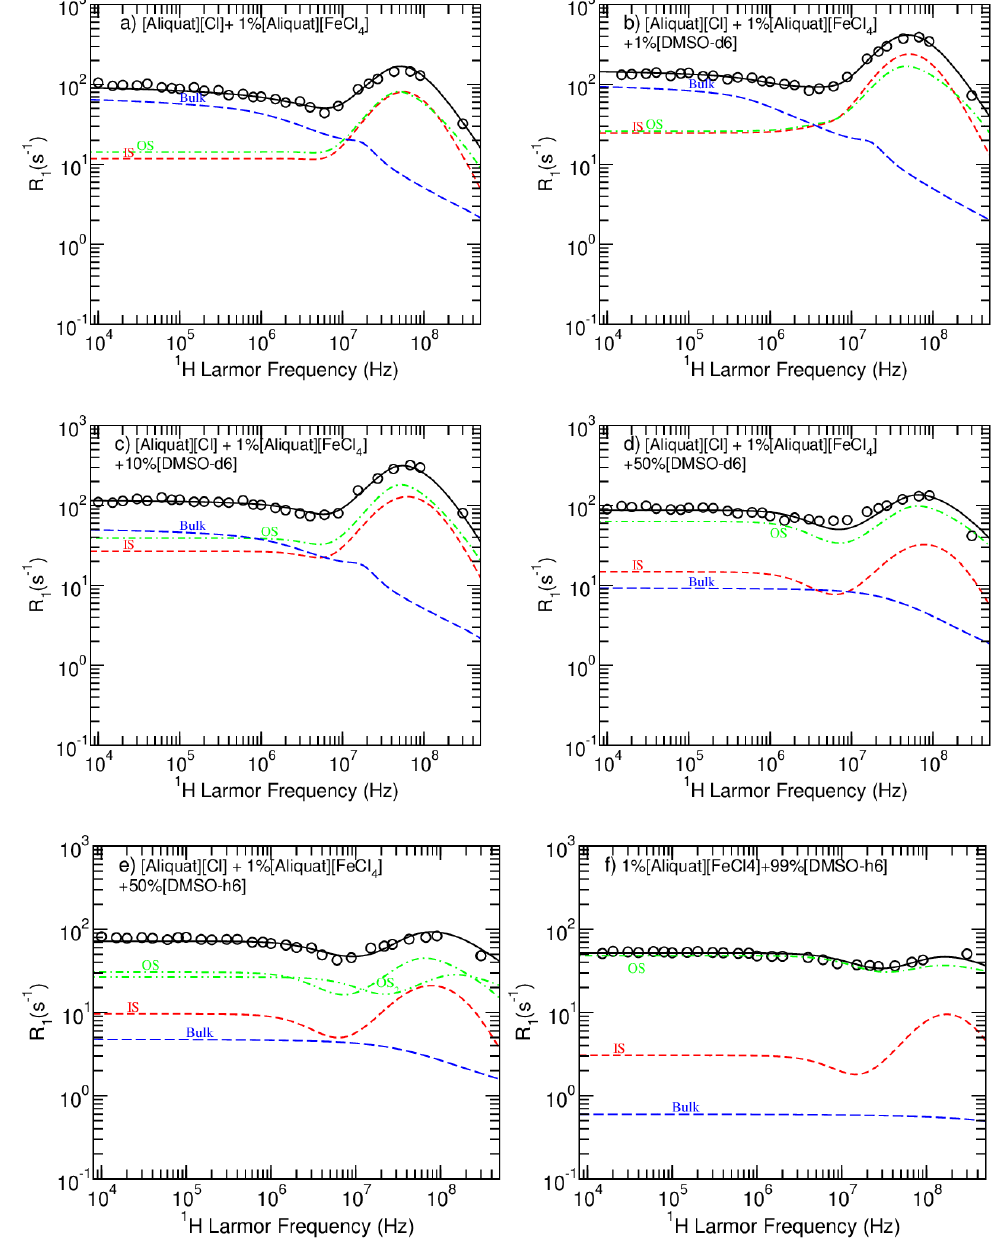
Figure 5. NMRD profiles obtained for the magnetic samples at 25 ◦ C. The blue curve is the sum of the non-paramagnetic relaxation, the red contribution related to the inner sphere paramagnetic relaxation process and the green contribution describes outer sphere paramagnetic